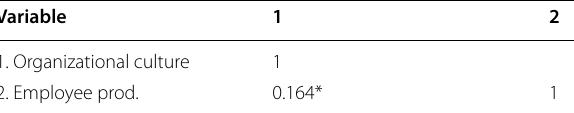
Table 7 Correlation matrix for main variables